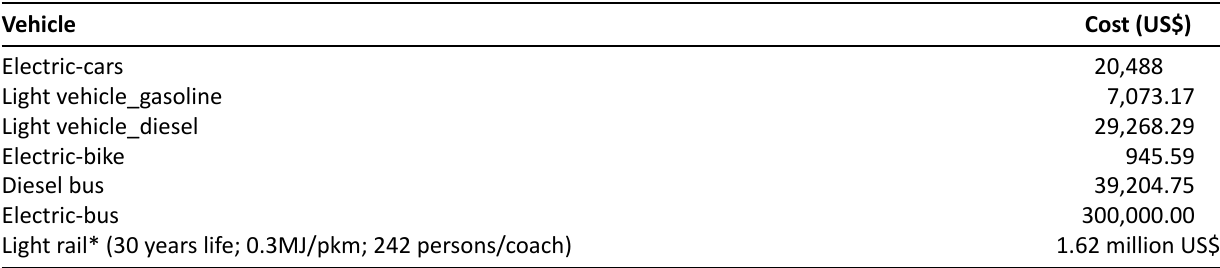
Table A7. Cost of passenger vehicle (IUT India, 2012*; RSTA, Personal Communication, October 19, 2016; Zhu et al., 2016). Vehicle